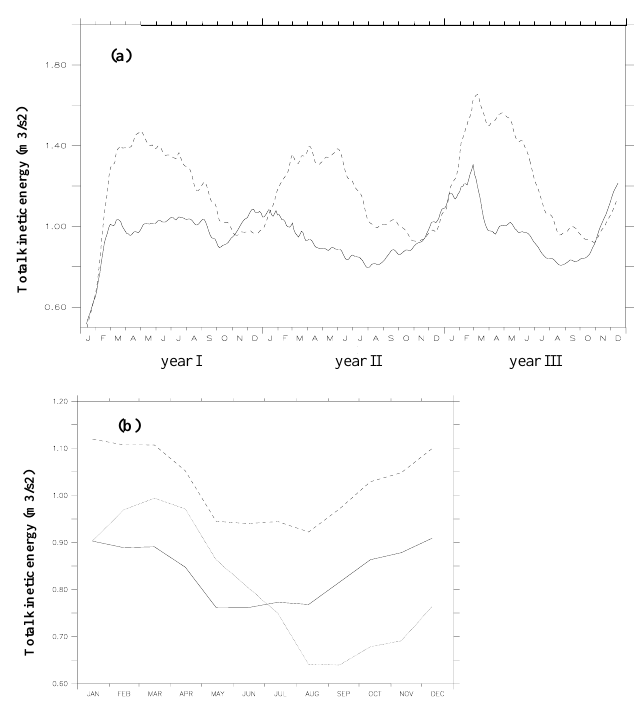
Fig. 1. Temporal evolution of the total kinetic energy vertically inte- grated, horizontally averaged, and normalized by the mean density ρ 0 . (a) RM model. Full line: integration between 0 and 100m; dashed line: integration between 100m and 500m. (b) GM model. Full line: integration between 0 and 105m; dash-dotted line: inte- gration between 0 and 140m, dashed line: integration between 105 and